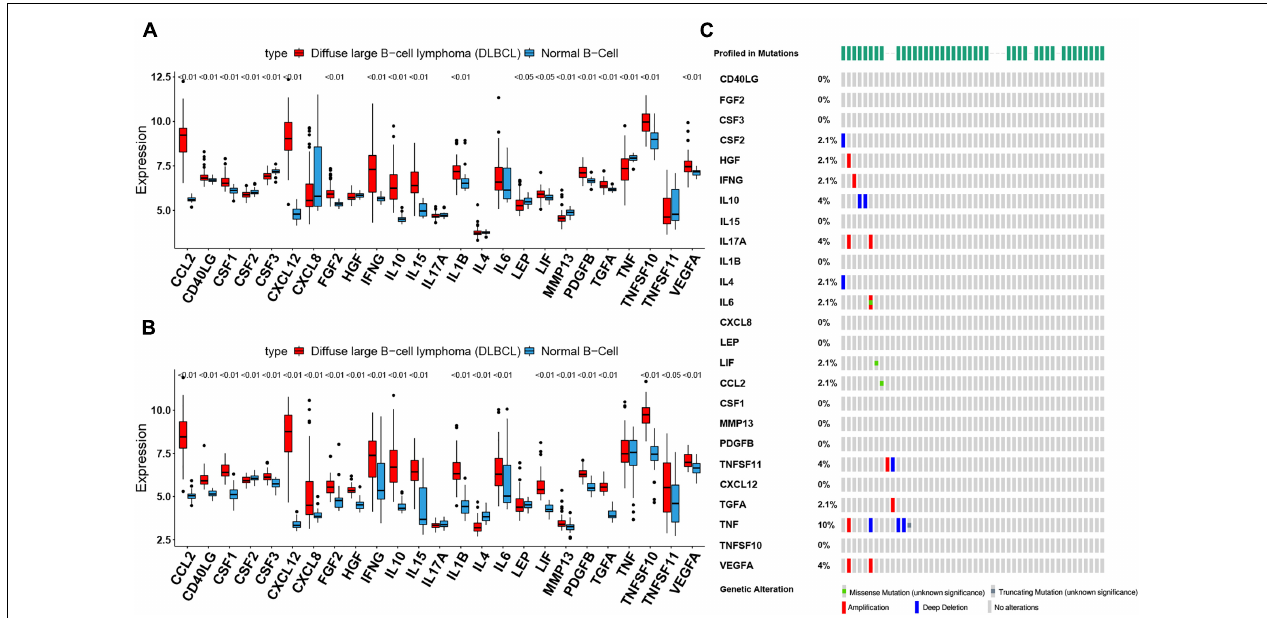
FIGURE 1 | The landscape of cachexia-inducing factors in the diffuse large B-cell lymphoma (DLBCL). (A,B) Expression levels of 25 cachexia-inducing factors in DLBCL and normal B cell from human tonsils ( A , GSE56315; B , GSE12195). The black dots represent outliers. (C) The mutation frequency of 25 CIFs in 48 patients with DLBCL from The Cancer Genome Atlas